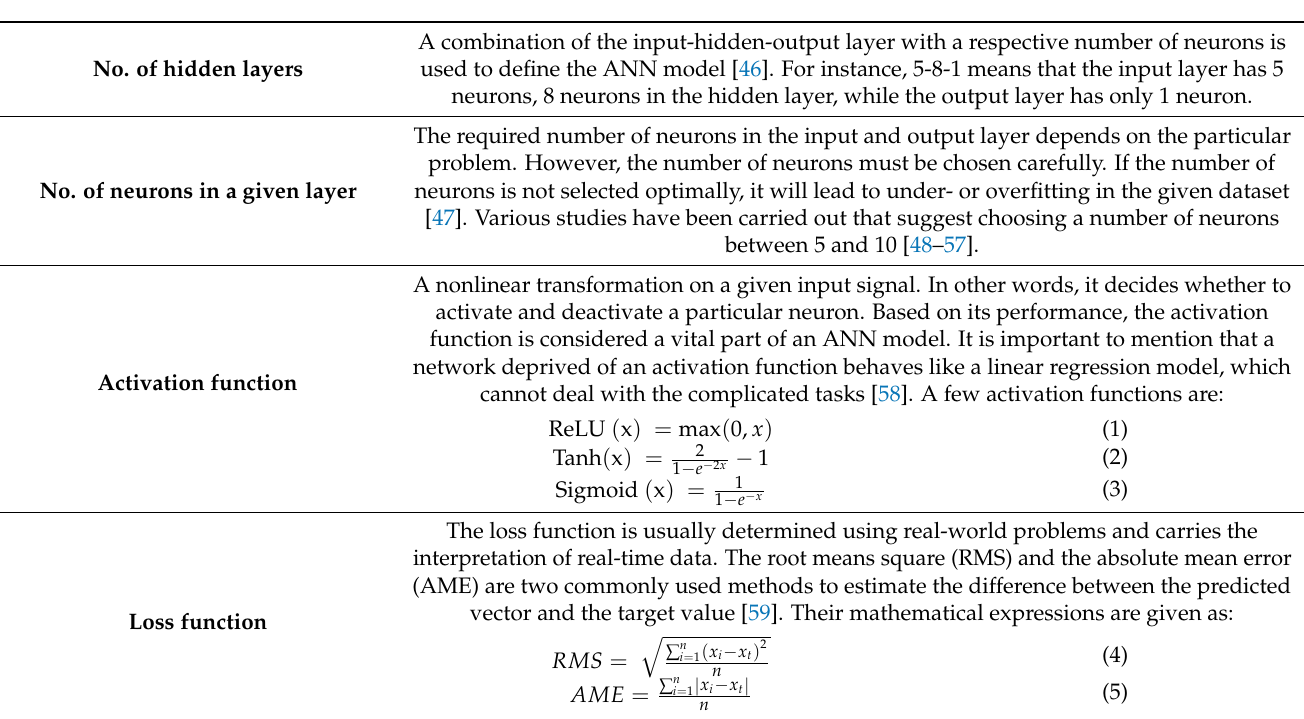
Figure 8. Structure of ANN [45]; with permission from Elsevier. Table 3 discusses the structure of an ANN in detail. Table 3. Structure of an ANN